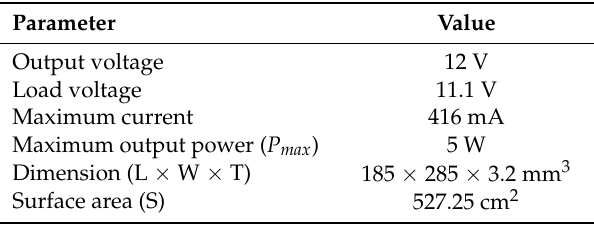
Table 3. Characteristics of the adopted solar